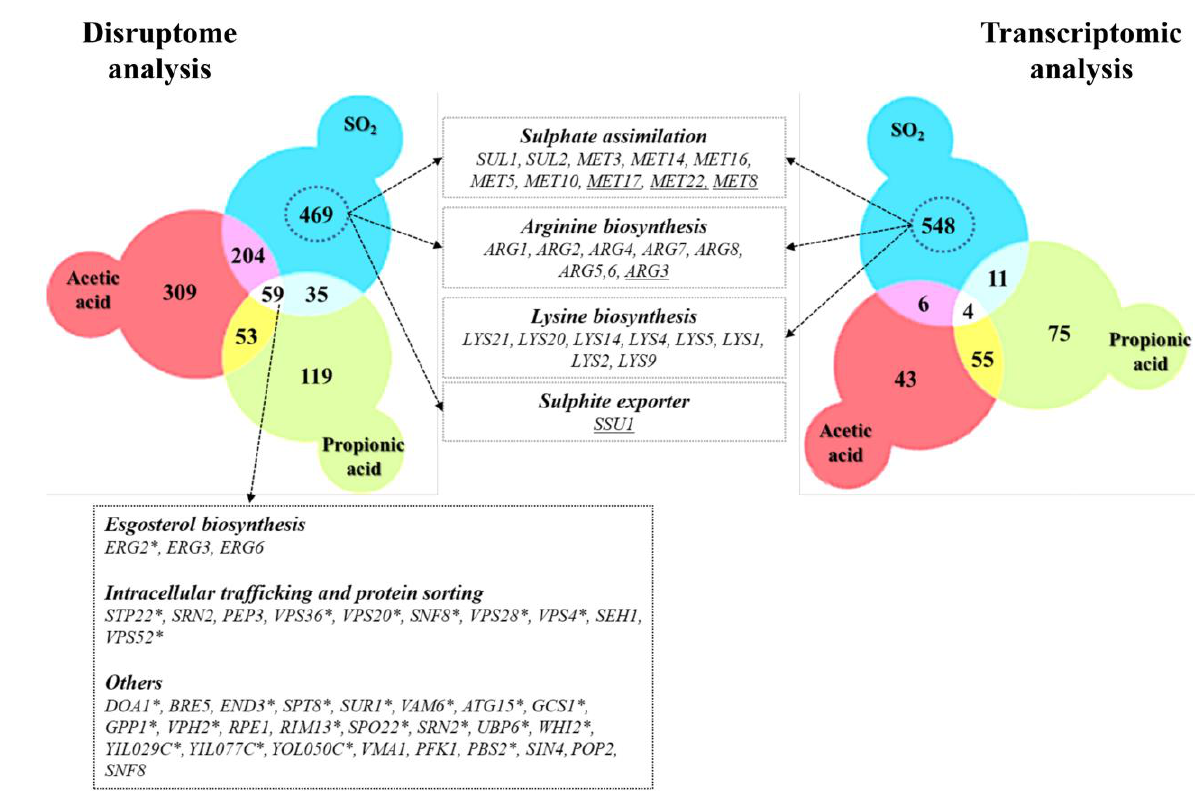
FIGURE 5. Venn diagrams comparing genes that were found to confer resistance to SO 2, propionic and acetic acids (left panel) and the set of genes up-regulated by SO 2 with those responding to acetic or propionic acids (right panel). Genes with asterisk corresponds to the MDR (multidrug resistance) genes and underlined genes represents the identified SO 2 -resistance genes with those that were found to be transcriptionally activated in response to this